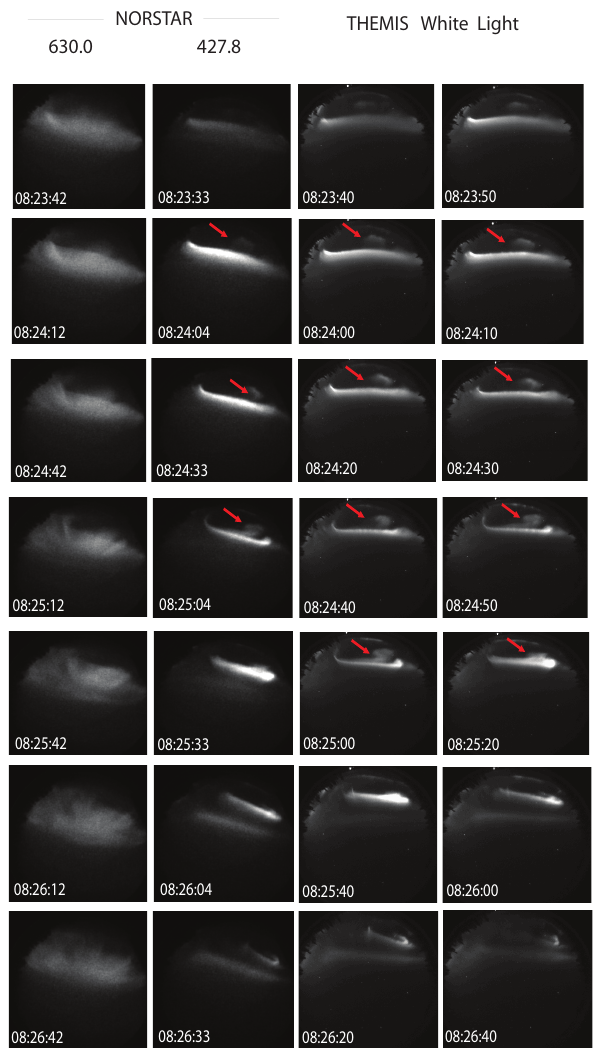
Fig. 6. The time sequence of the raw auroral images from the multi- spectral (630.0nm and 427.8nm) and THEMIS white light ASI at Fort Smith on 1 March 2009 showing the formation of an auroral vortex when THEMIS satellites were in the same local time